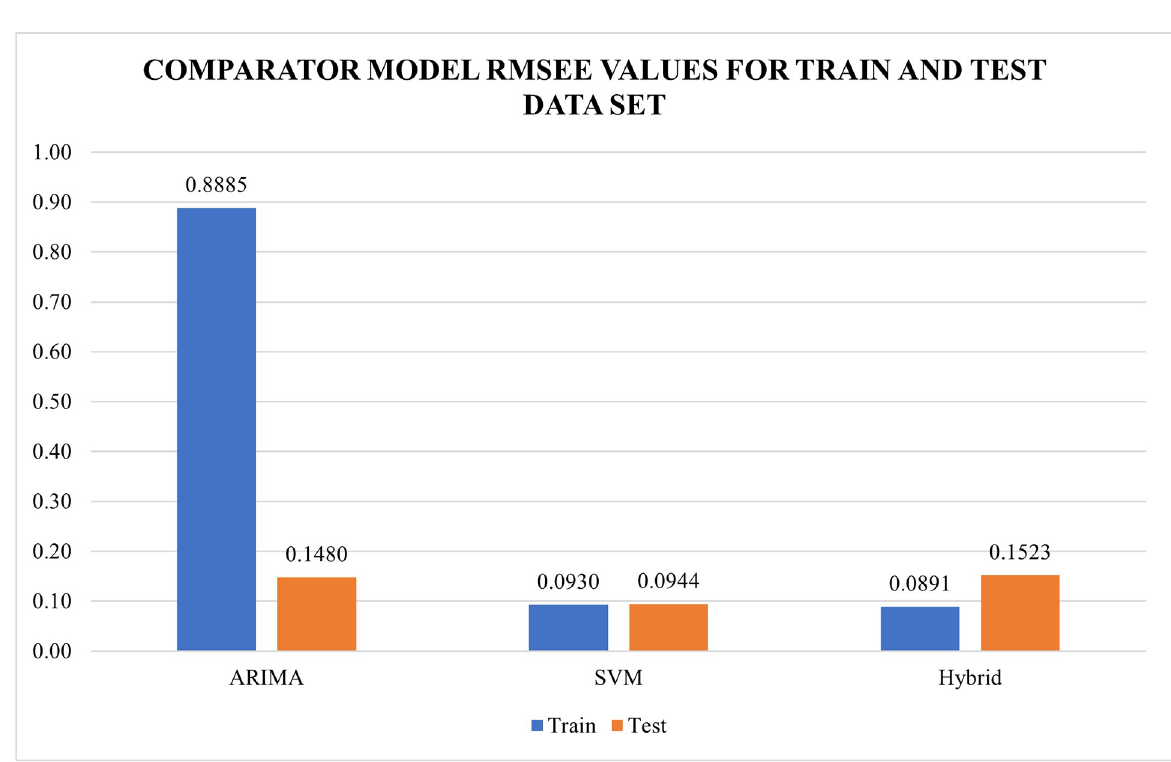
Fig 5. RMSE values for both test and training dataset for ARIMA model, SVR model and ARIMA-SVR hybrid model.